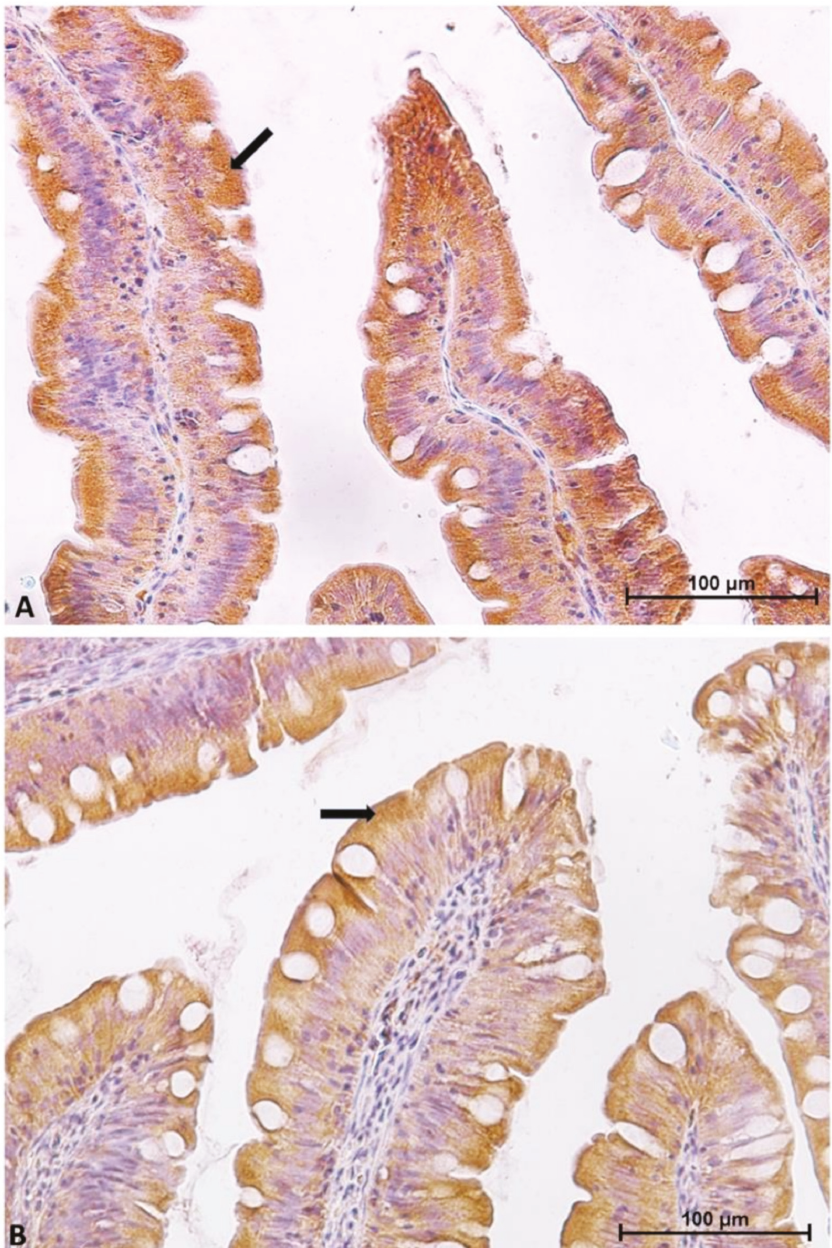
Figure 2. Immunolocalization of peptide transporter 1 (PepT1) in pyloric caeca ( A ) and in the first segment of the mid-intestine ( B ). The molecule is localized in the brush border and in the apical part of the enterocyte cytoplasm (arrows).